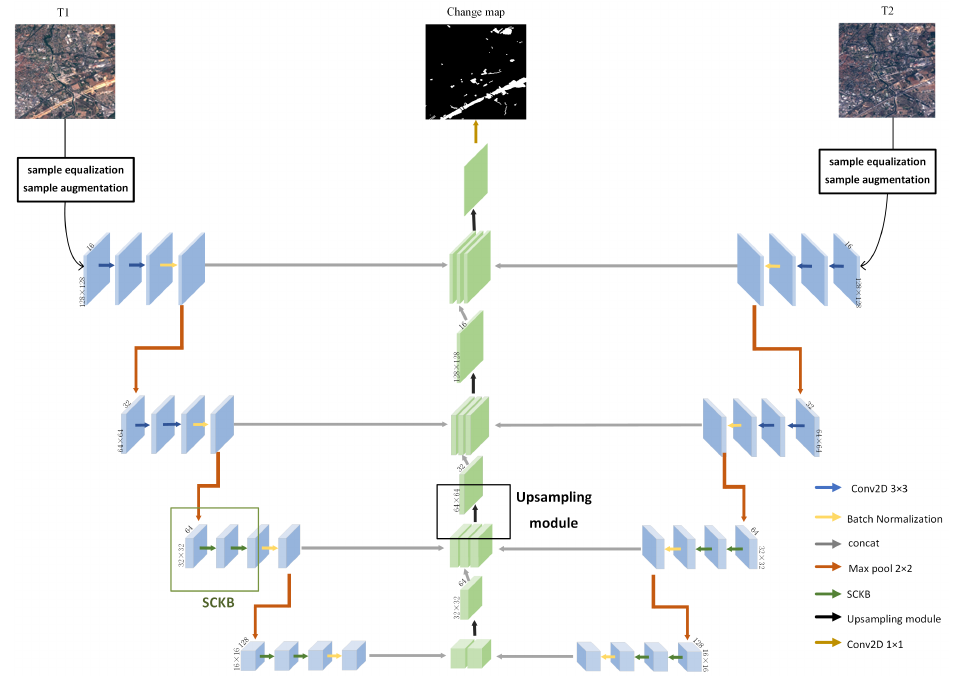
Figure 2. Architecture of the proposed